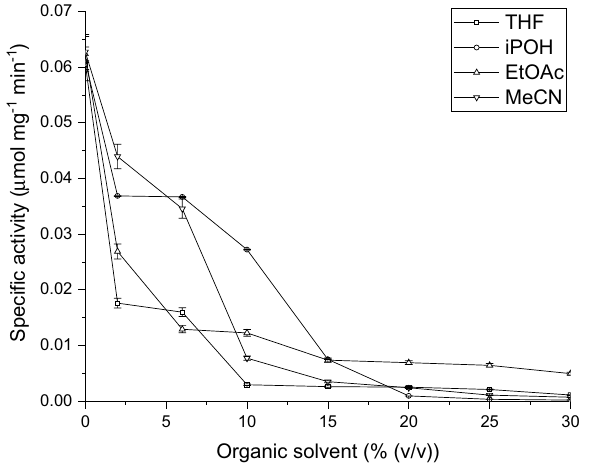
Figure 3. Retention of transketolase catalytic activity in cofactor-free systems with increasing concentrations of organic solvents. Apo-TK was compared for its stability to incubation with (open square)) THF, (open circle) isopropanol, (open triangle) ethyl acetate and (inverted open triangle) acetonitrile, in 50 mM Tris–HCl, pH 7.0 (plus 4.8 mM TPP, 18 mM MgCl 2 for holo-TK), for 3 h at 25 °C and 1000 rpm shaking. Enzyme activity was measured after a 20-fold dilution of the solvents, at 50 mM HPA and 50 mM GA in 2.4 mM TPP, 9 mM MgCl 2 , 50 mM Tris–HCl, pH 7.0. Error bars represent one standard deviation about the mean (n = 3).